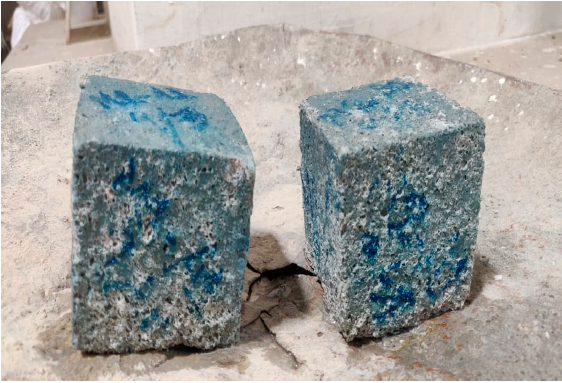
Figure 7. Deterioration of blended cement mortar when it is exposed to acid medium.